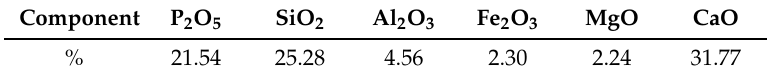
Table 1. Chemical composition of raw ore.